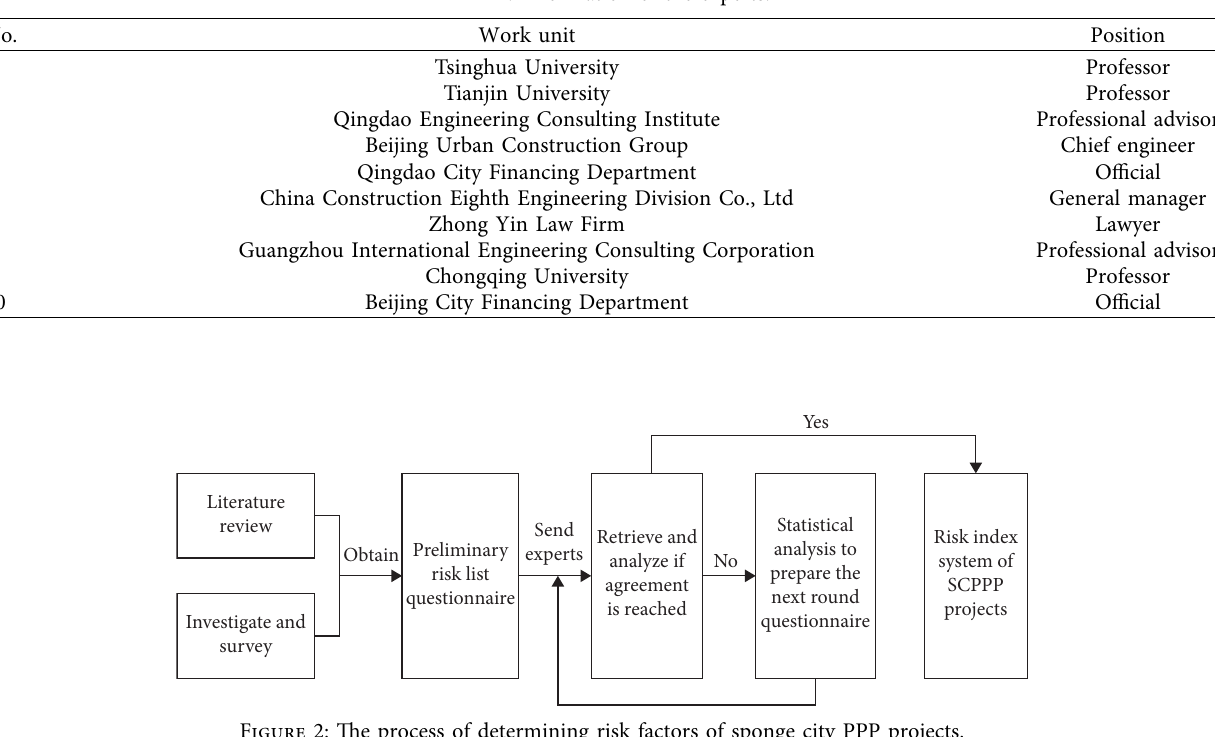
Figure 1: The constructed risk-sharing framework of this study. Table 1: Information of the experts.